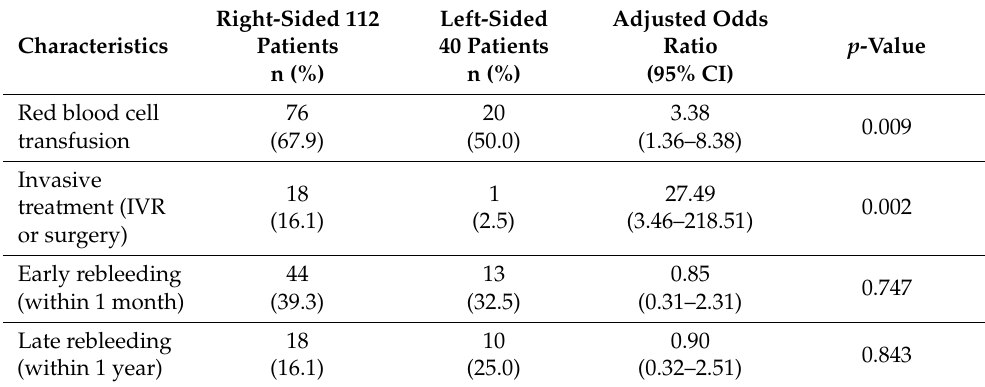
Table 3. Clinical differences between right-sided and left-sided diverticular